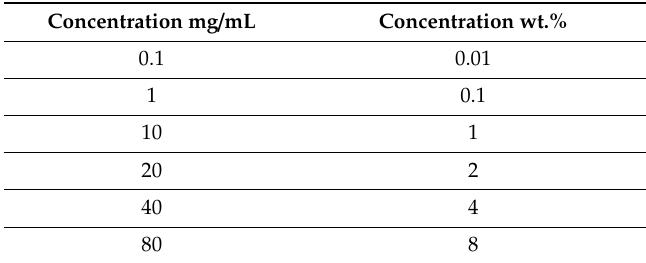
Table 1. Concentration of the PEG-GO suspensions used for the rheological